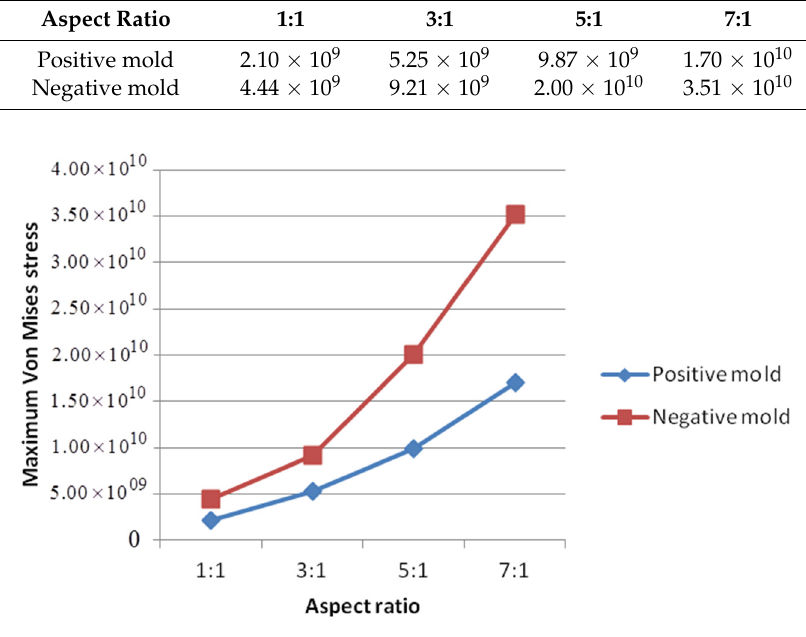
Figure 10. Maximum Von Mises stresses in completely filled different molds (units of Pa).